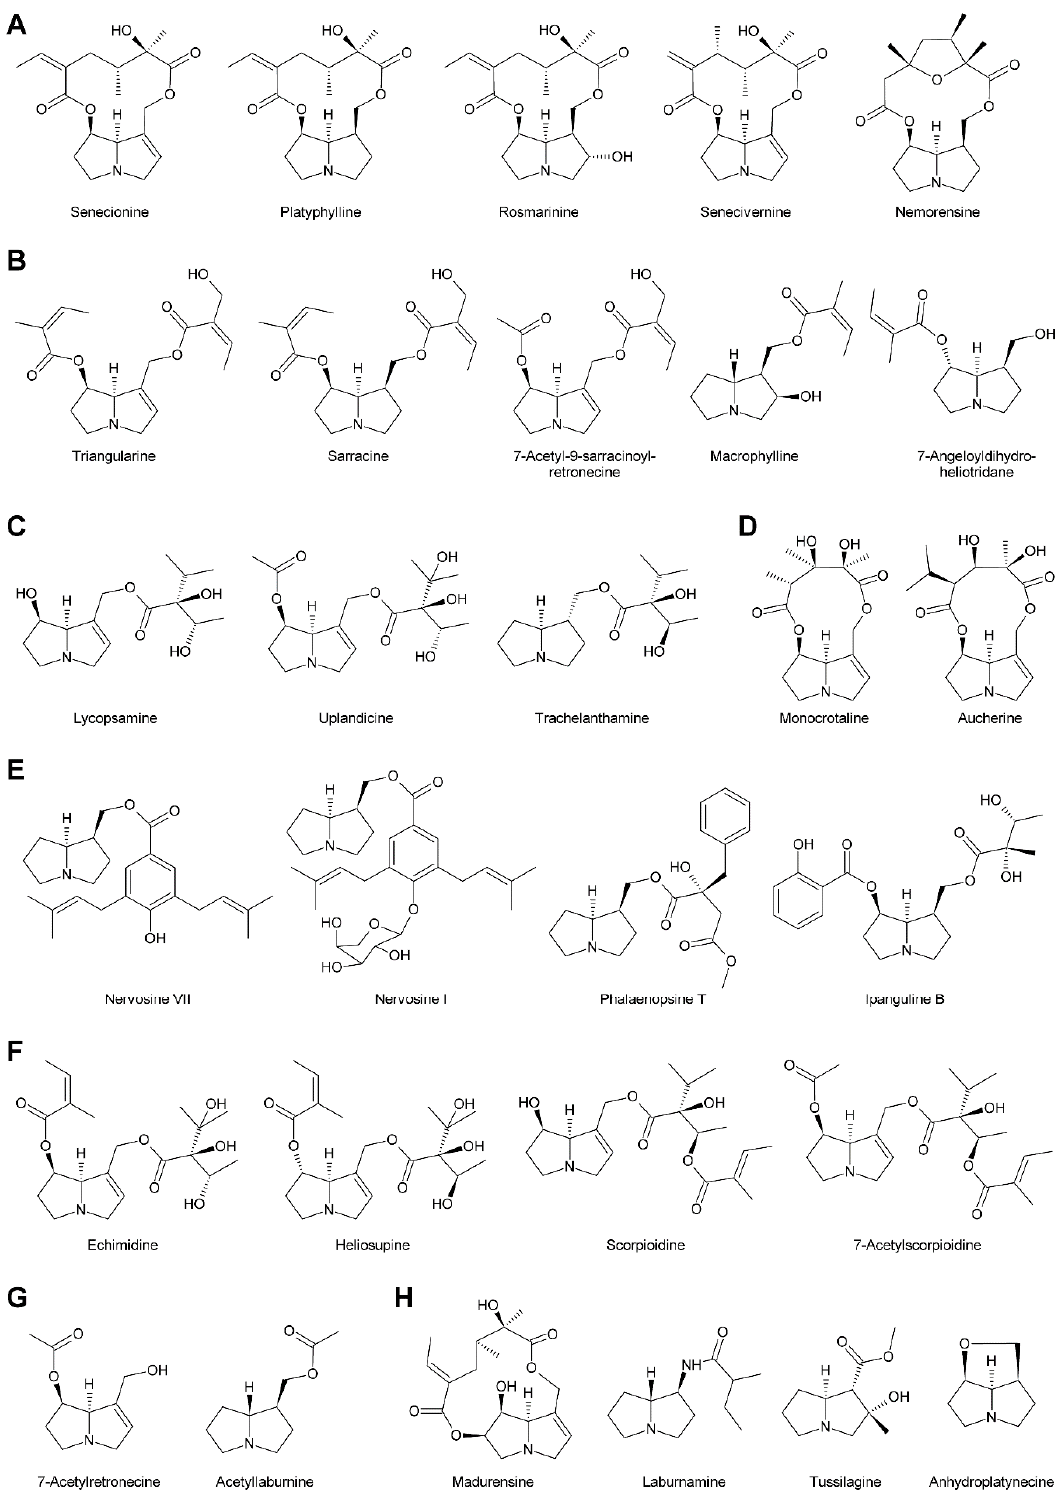
Figure 5. Linkage patterns of necic acids with necine bases. ( A ) Senecionine type. ( B ) Triangularine type. ( C ) Lycopsamine type. ( D ) Monocrotaline type. ( E ) Phalaenopsine/ipanguline type. ( F ) Compounds combining necic acids of triangularine and lycopsamine types. ( G ) Simple PAs. ( H ) PAs with unusual linkage patterns.